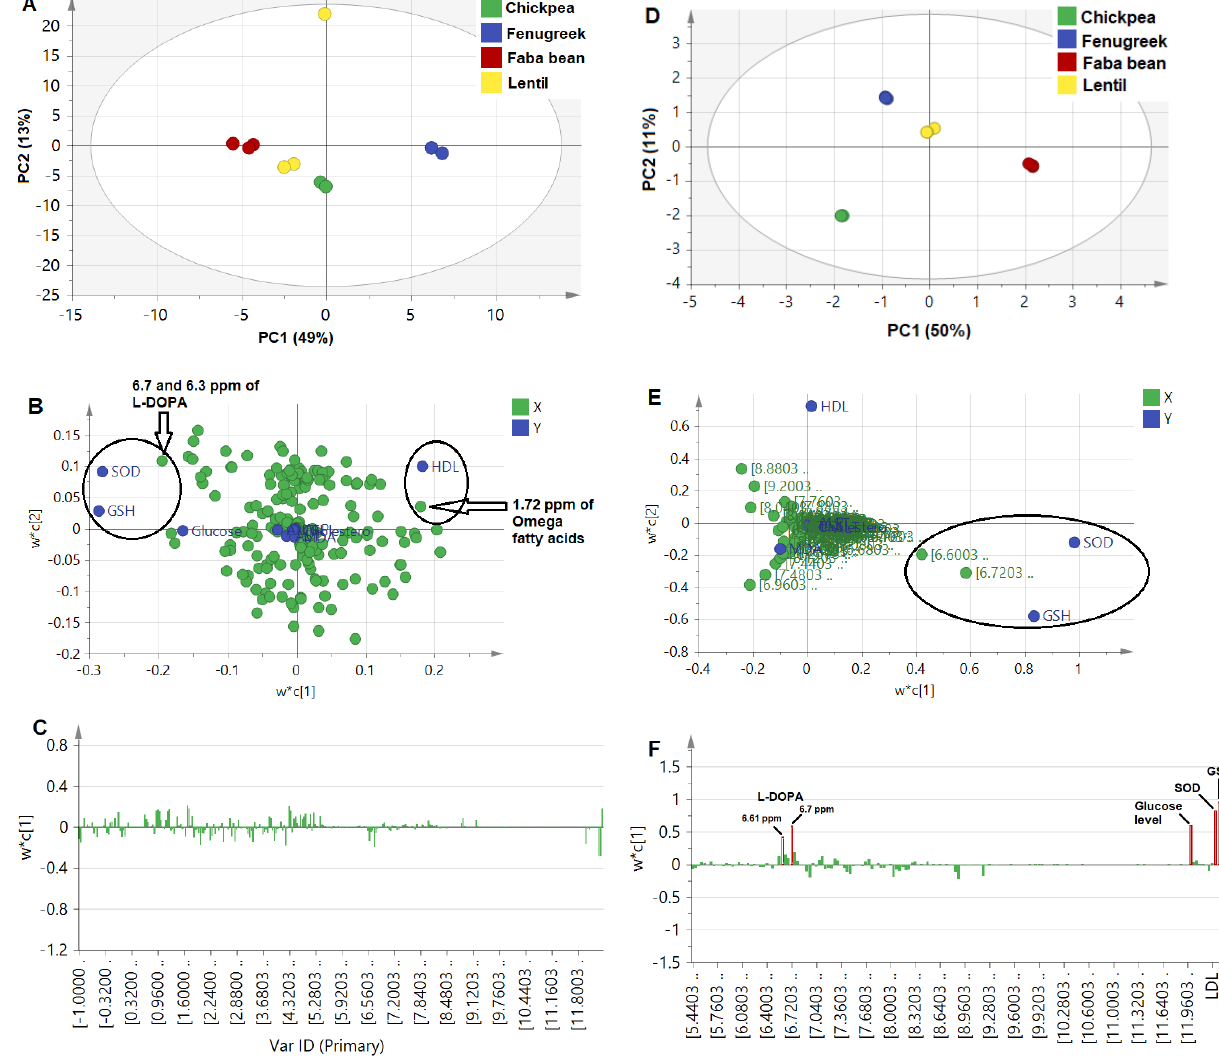
Figure 3. Untargeted PLS analysis for NMR spectral bins (0.04 ppm each) of the whole NMR scale ( δ H 0.0 − 11.0 ppm) in ( A − C ), in addition to aromatic region ( δ H 5.5 − 11.0 ppm) in ( D − F ). ( A , D ): Score plot, ( B , E ): Loading scatter plot, and ( C , F ): Loading bar plot. It should be noted that ellipses drawn do not reflect statistical significance.